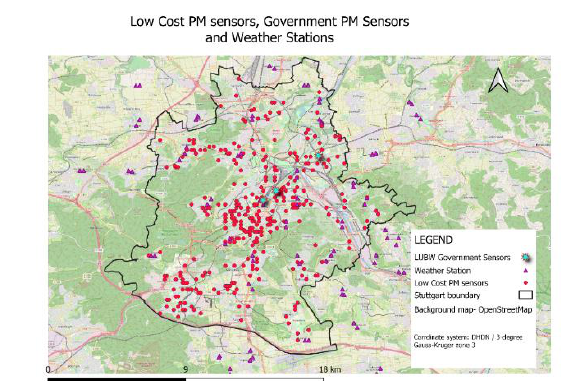
Figure 3. Weather Stations and PM sensors after filtering to 11 th Nov 2019 and Stuttgart boundary